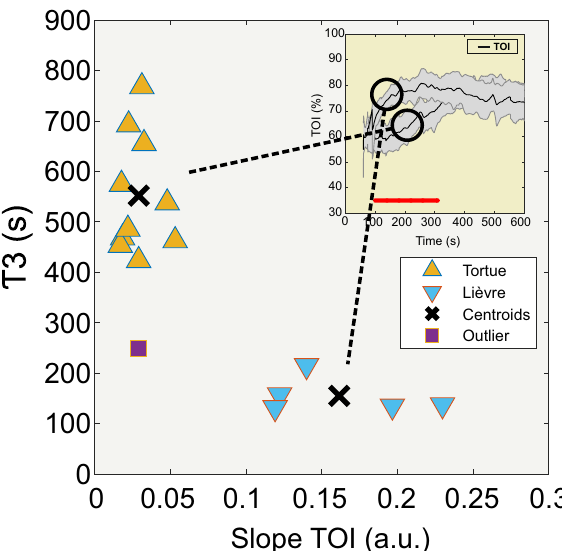
Figure 3. Two-dimensional clustering results are based on the parameters of the slope of the TOI and τ3. We observed two distinct clusters, identified as “Lièvre” (in blue, n = 5) and “Tortue” (in orange, n = 10). The inset presents the average TOI curves (with std) corresponding to each cluster.